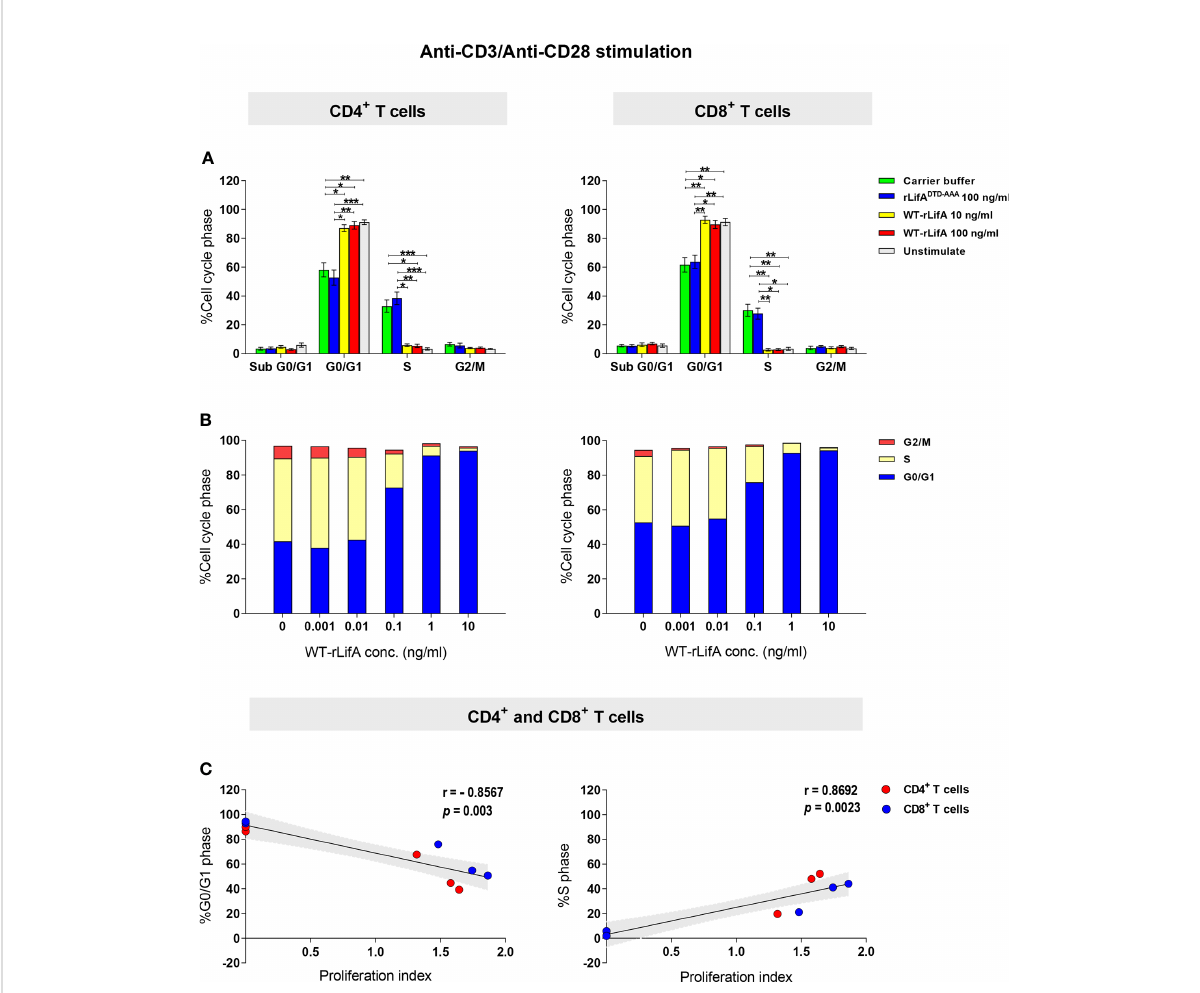
FIGURE 10 Lymphostatin arrests the cell cycle in G0/G1 phase in anti-CD3/anti-CD28-stimulated CD4 + and CD8 + T cells. (A) Distribution of sub G0/G1, G0/G1, S, and G2/M phases in the unstimulated (without treatment) and anti-CD3/anti-CD28-stimulated CD4 + and CD8 + T cells treated with rLifA DTD-AAA , WT-rLifA, or carrier buffer. Data represent the mean of 8 healthy donors ± S.E.M. * p < 0.05, ** p < 0.01, *** p < 0.001 using Kruskal-Wallis test followed by Dunn ’ s test. (B) Distribution of G0/G1, S, and G2/M phases in anti-CD3/anti-CD28-stimulated CD4 + and CD8 + T cells treated with varied concentrations of WT-rLifA or left untreated (cells with mitogen; no tested protein). Data are from 3 healthy donors. (C) A Spearman ’ s rank-order correlation was run to determine the relationship between proliferation and cell cycle distribution of the percentage of cells in G0/G1 and S phases in anti-CD3/anti-CD28-stimulated CD4 + and CD8 + T cells treated with WT-rLifA (0.001 to 10 ng/ml). Each circle represents the mean of proliferation index from 8 healthy donors. The black line is the regression line; the shaded area is the 95% Con fi dence